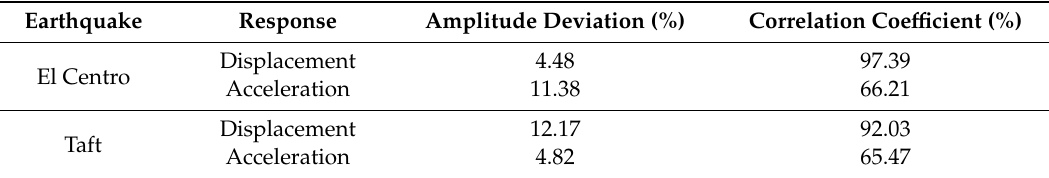
Table 4. Error comparison between shaking table substructure testing (STST) and the reference shaking table test